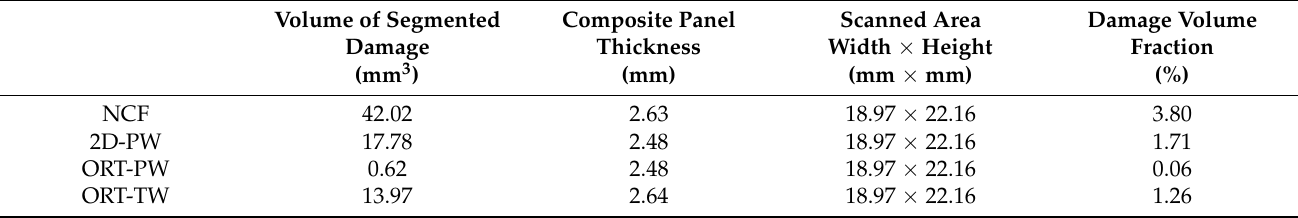
Figure 10. 3D X-ray CT reconstructed volume with the segmentation of damage due to impact highlighted in red ( left ) and 2D top view ( right ). Table 2. Summary of the X-ray segmentation